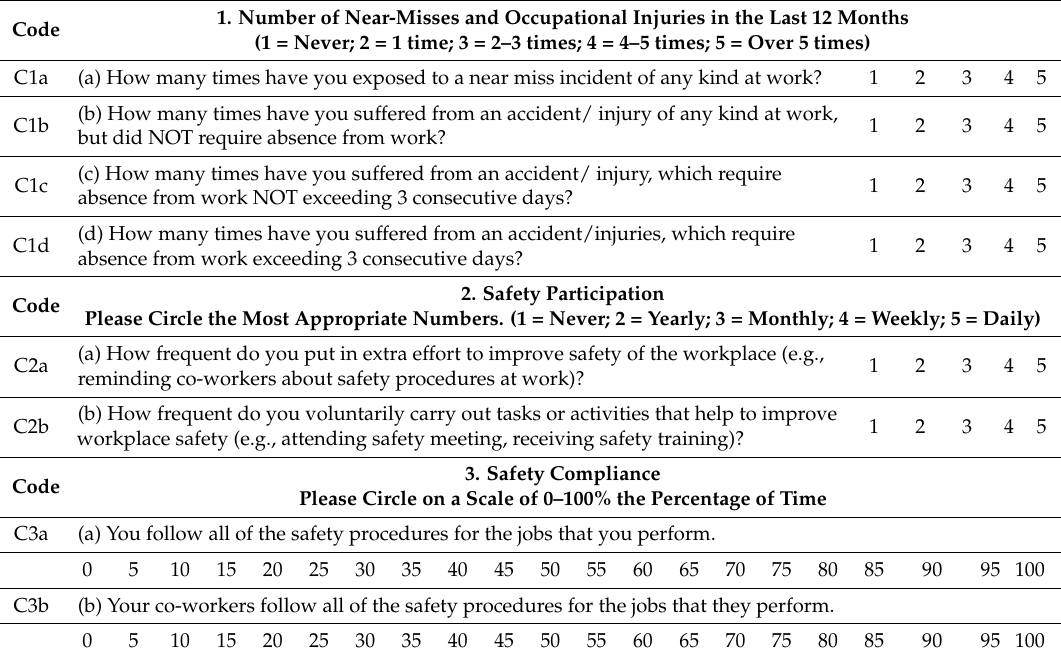
Table A2. Measures of safety behaviors and safety outcome of